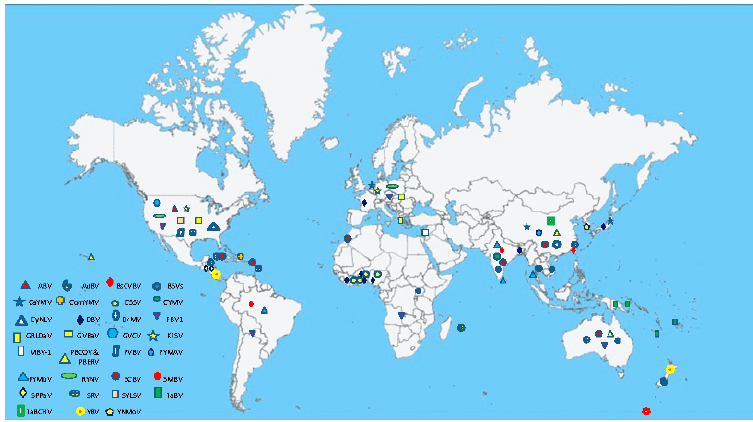
Figure 3. Worldwide distribution of badnaviruses. Details of acronyms used are provided in Supplementary Materials Table S1. Supplementary Materials Table